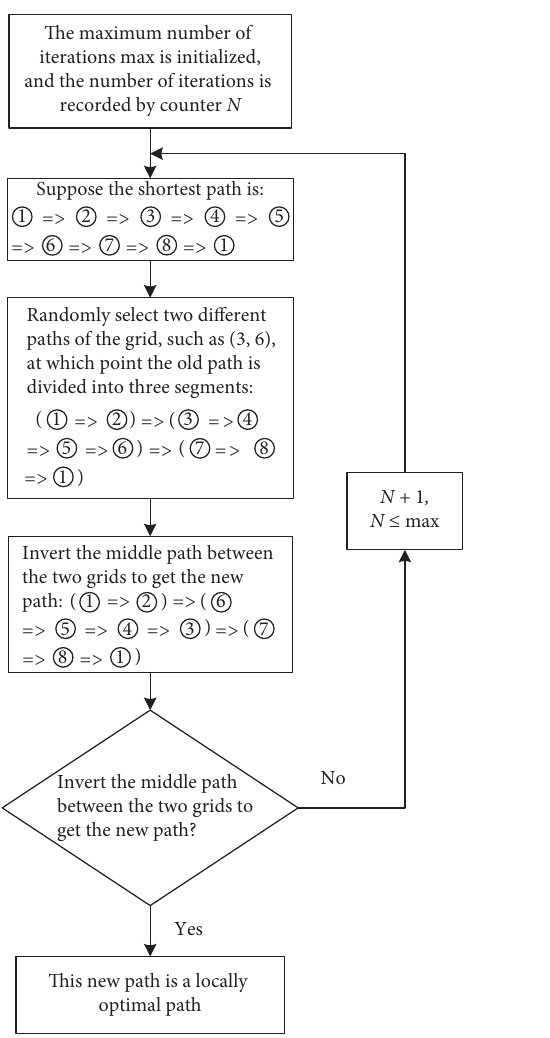
Figure 3: Local optimization process of the 2-opt